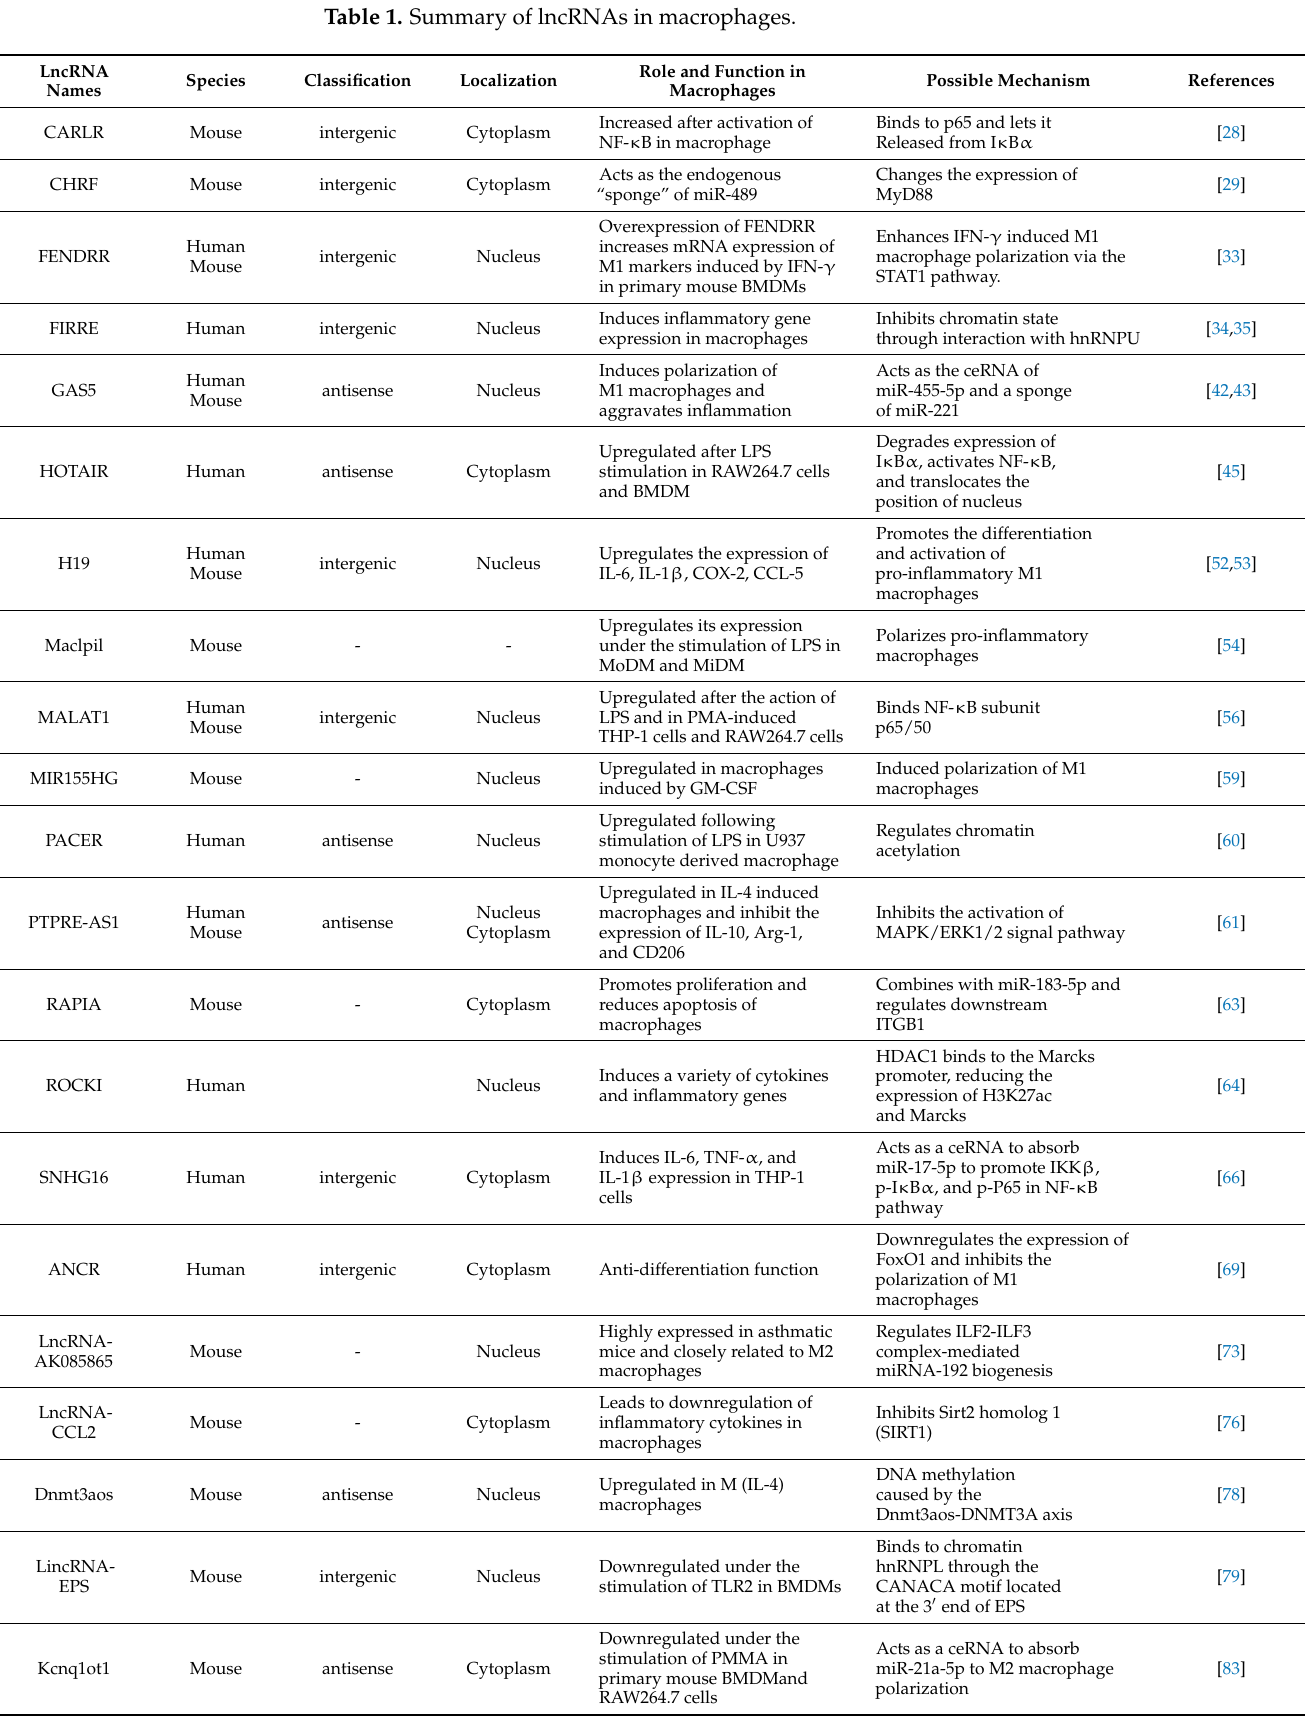
Table 1. Summary of lncRNAs in